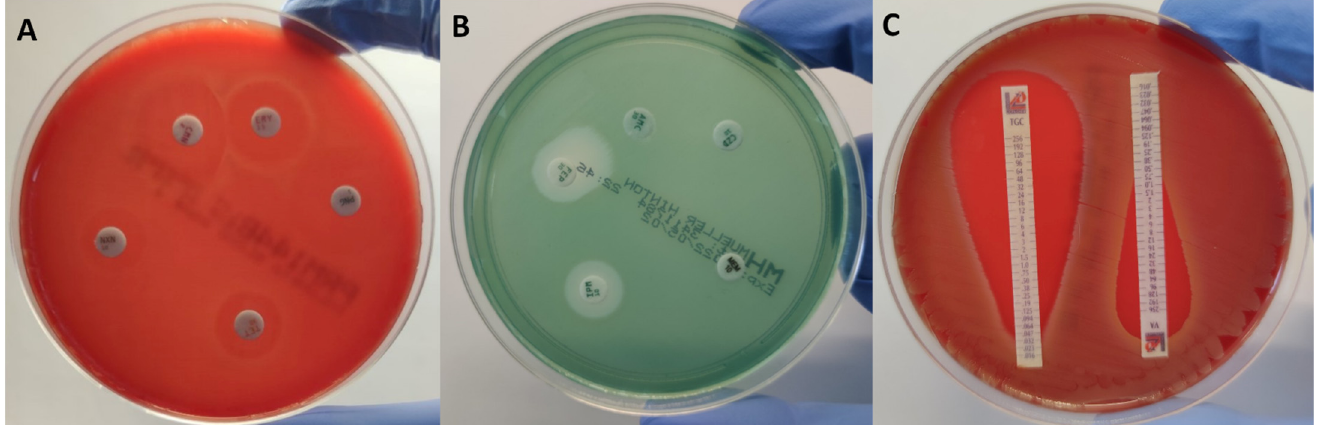
Figure 2. Disk diffusion and gradient test of various bacterial isolates. ( A )—Antimicrobial susceptibility of Streptococcus pyogenes showing iMLS phenotype, using disk diffusion method. ( B )—Antimicrobial susceptibility of extended-spectrum beta-lactamase-producing Pseudomonas aeruginosa , using disk diffusion method. ( C )—Gradient test of Enterococcus spp. iMLS phenotype—inducible macrolide, lincosamide, and streptogramin phenotype.